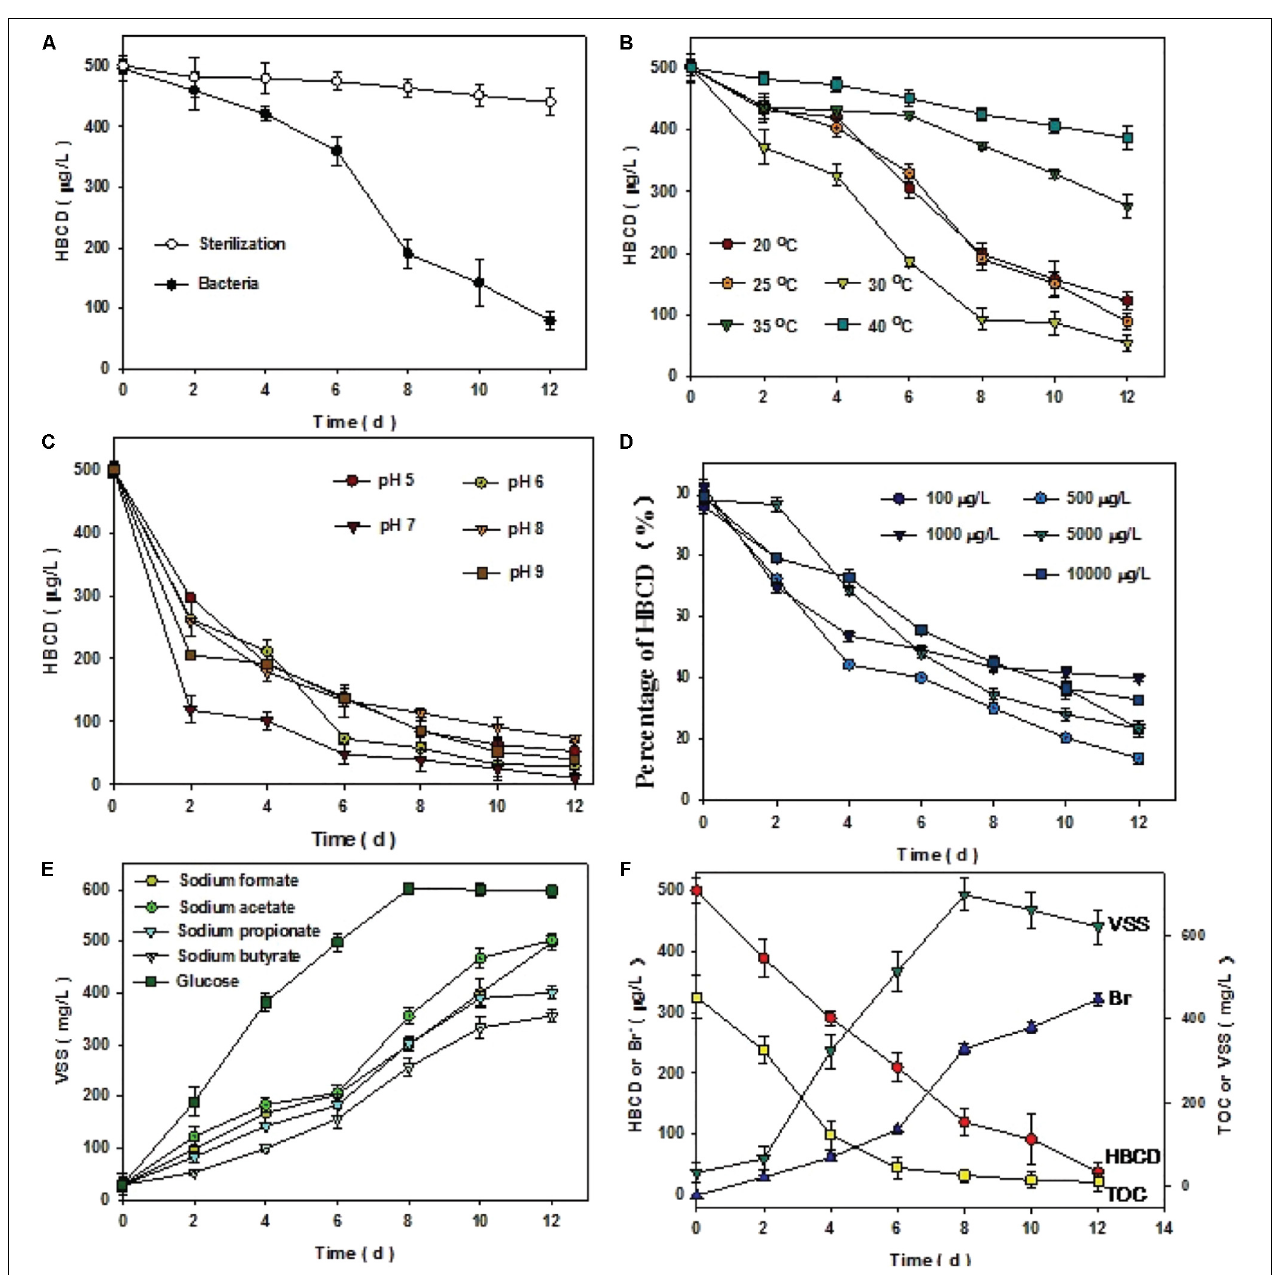
FIGURE 2 | Comparison of sterilization and bacterial treatment (A) . Optimal conditions of microbial consortium degrading HBCD after enrichment of 300 days (B–E) . Variation of VSS, TOC, HBCD, and bromide ions under the optimal condition (F) . The left vertical coordinate represented that the concentration of HBCD or bromide ions (Br − ), and the right coordinate represented the concentration of TOC or VSS. The initial concentration of HBCD and TOC were 500 µ g · L − 1 and 452 mg · L − 1 , respectively. The average of each gram of protein content in the mixed liquor is equal to 1.29 g biomass, i.e., VSS. Error bars represent the deviation of three